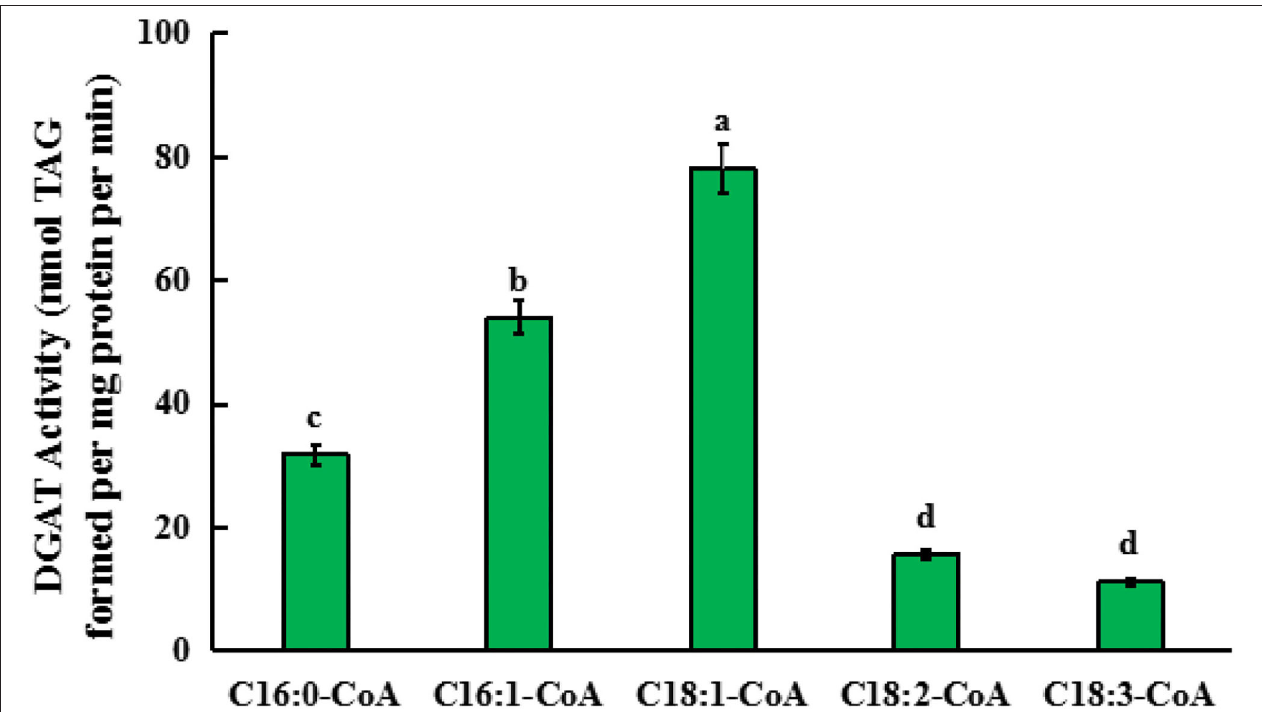
FIGURE 6 | Quantification of the substrate specificity of GmDGAT3-2 for different acyl-CoAs by in vitro assay. Triglycerides (TAGs) formed when enzyme protein extracted from E. coli BL21 expressing GmDGAT3-2 (40 ng protein) were administered 5 µ M of each acyl-CoA together with 100 µ M of sn-1,2-DAG (18:1n9/16:0 DAG). Bar values are means ± SE ( n = 3). Small letters (a and b) show significant difference ( P <